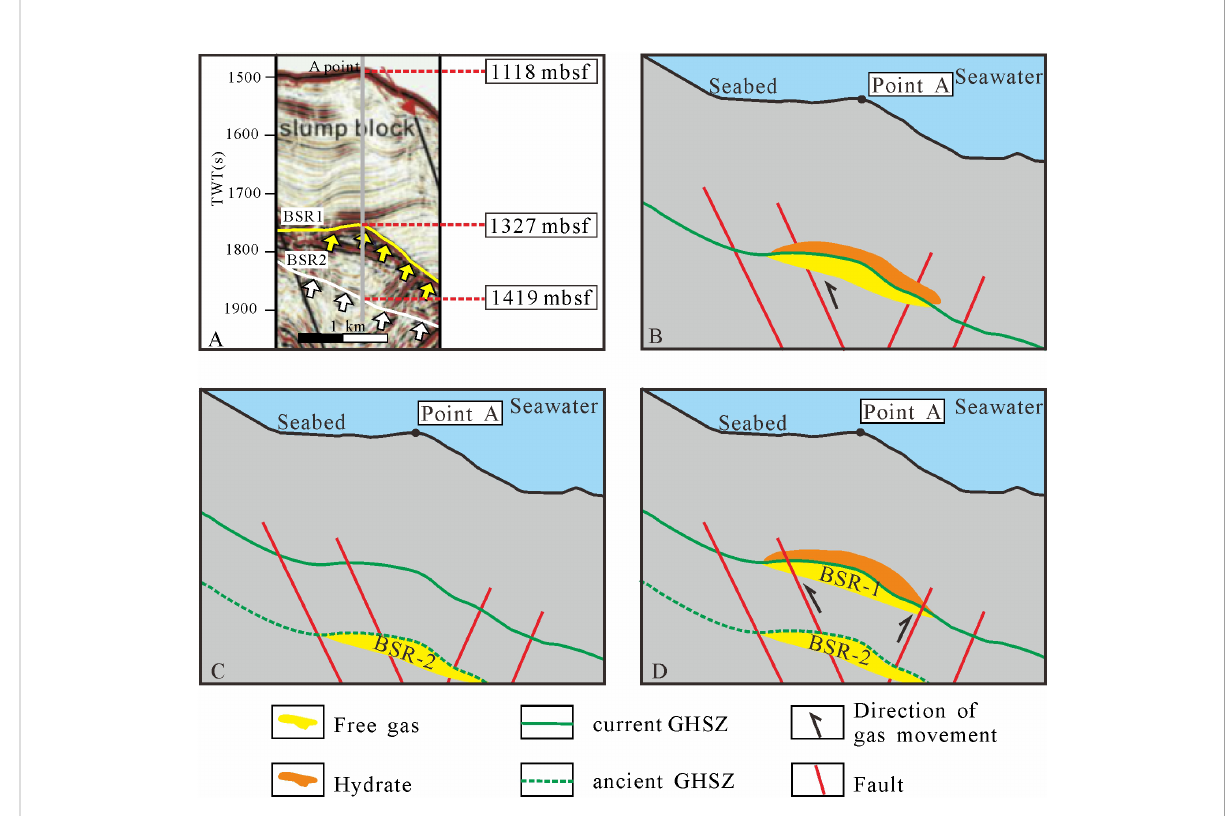
model due to thinning of the GHSZ at point A is proposed (Figure 10). Before 0.357 Ma, biogenic gas migrated to the GHSZ through faults, mud volcanoes and other channels to form gas hydrate and formed the early BSR (BSR-1) (Figure 10B). During